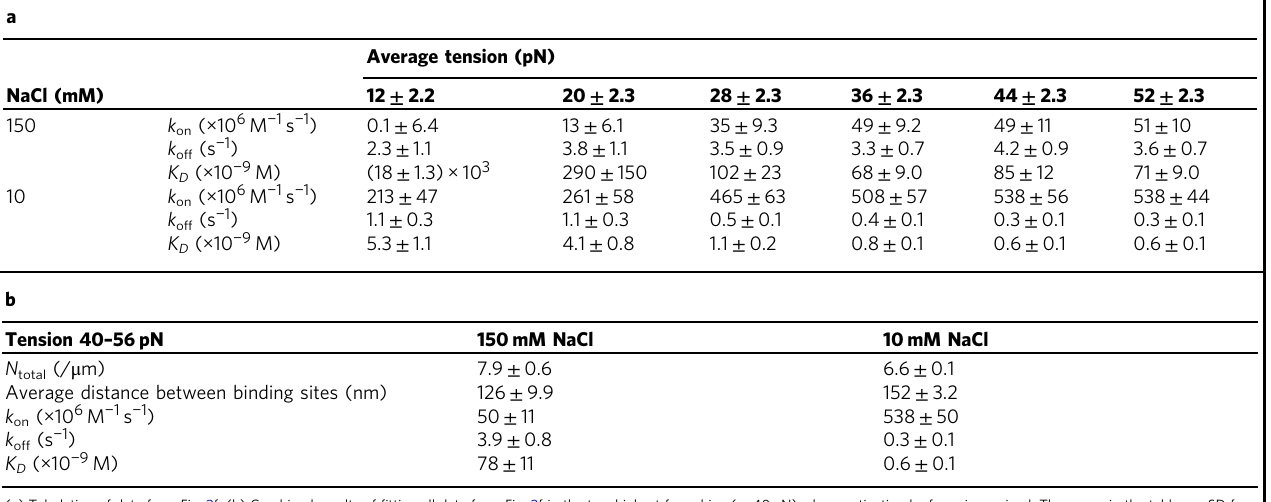
Table 1 VWF-GPIb α binding af fi nity a